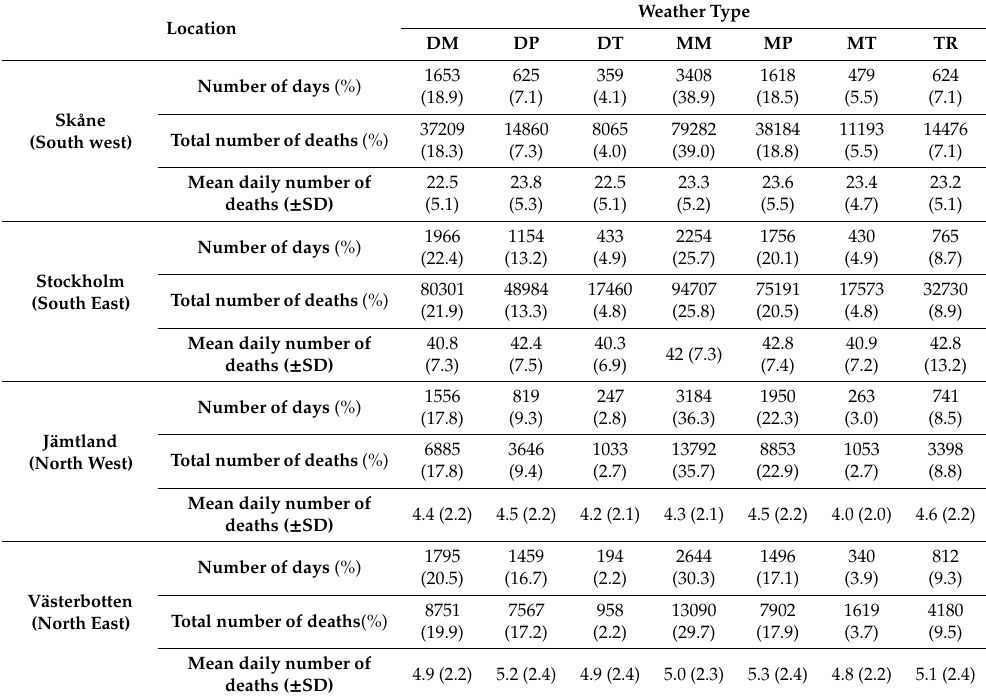
Table 2. Descriptive statistics of weather types and death counts in the four study locations,